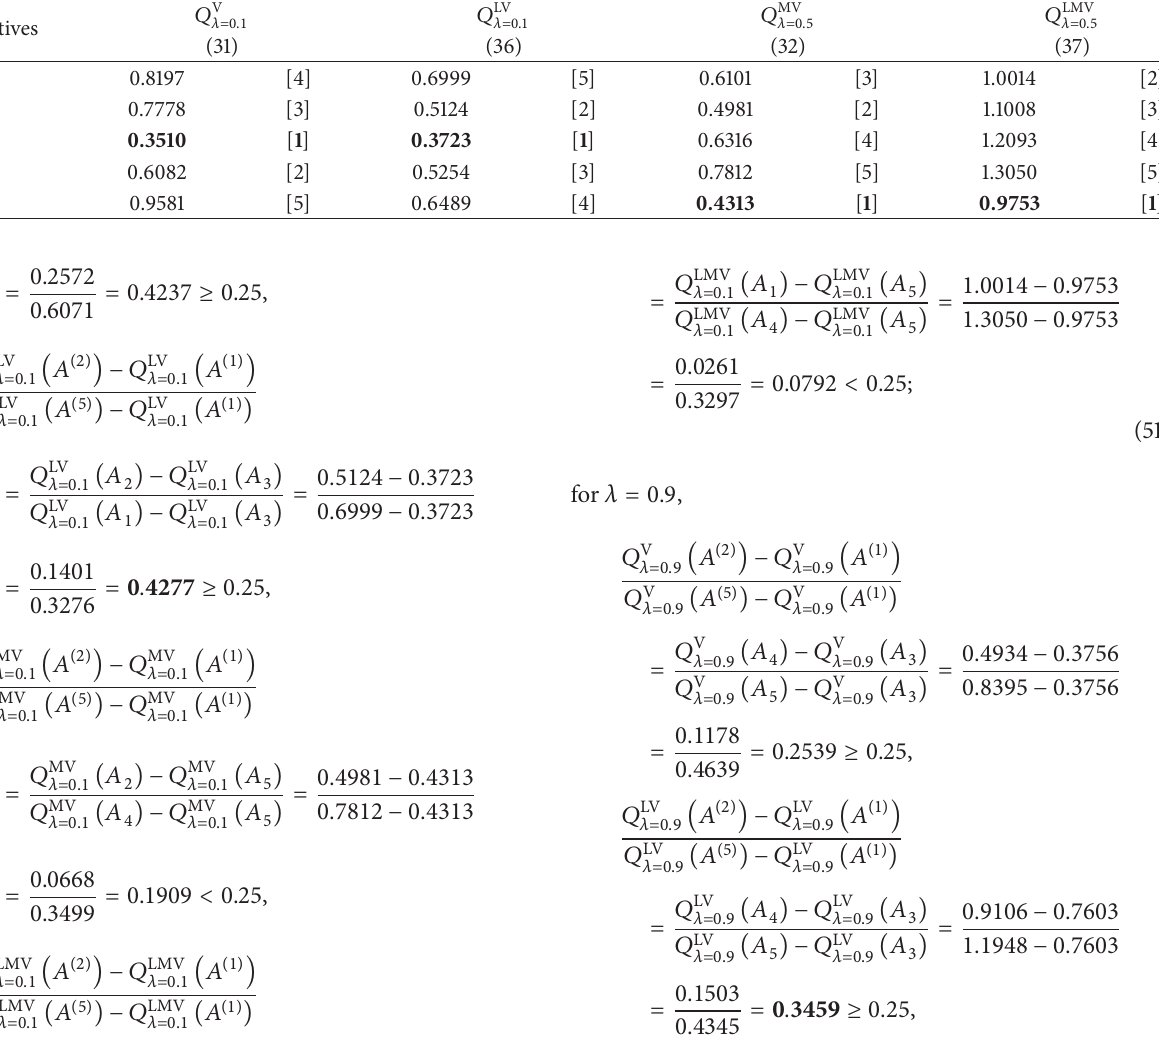
Table 12: Ranking of alternatives with respect to values of 𝑄 V , 𝑄 LV , 𝑄 MV , and 𝑄 LMV for 𝜆 = 0.1